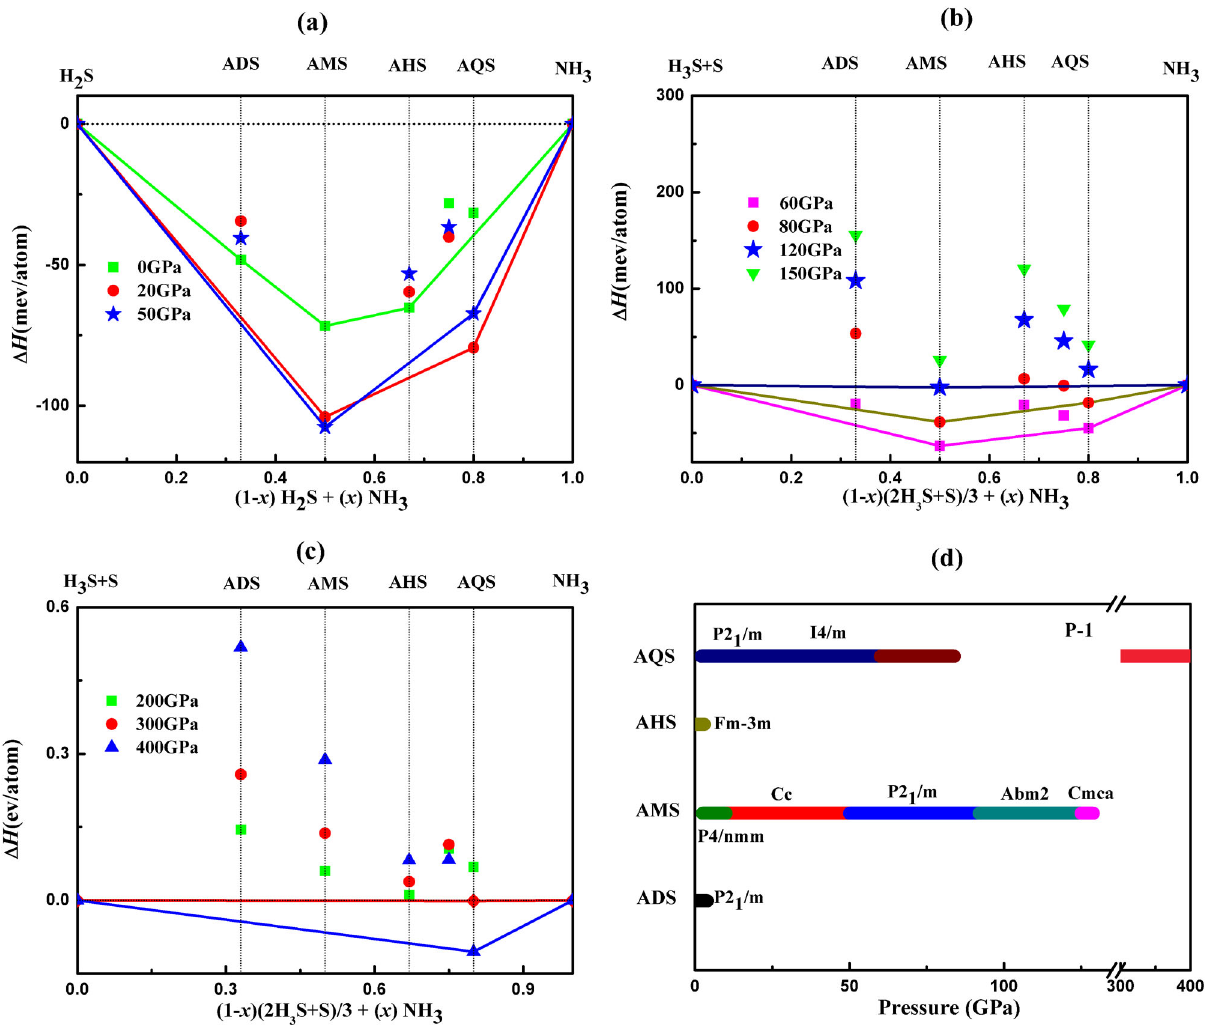
Fig. 1 Convex hulls and ground state phase diagram of the H 2 S-NH 3 system. a Convex hulls relative to H 2 S and NH 3 up to 50 GPa, b convex hulls relative to H 3 S + S and NH 3 from 60 to 150 GPa, c convex hulls relative to H 3 S + S and NH 3 from 200 to 400 GPa, and d ground state phase diagram under pressure. Colored bars indicate stability ranges of phases as labeled by space group, for different H 2 S-NH 3